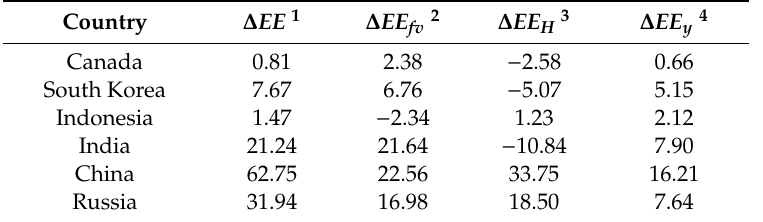
Table 2. Theoretical optimization quantity of embodied energy consumption (EJ).